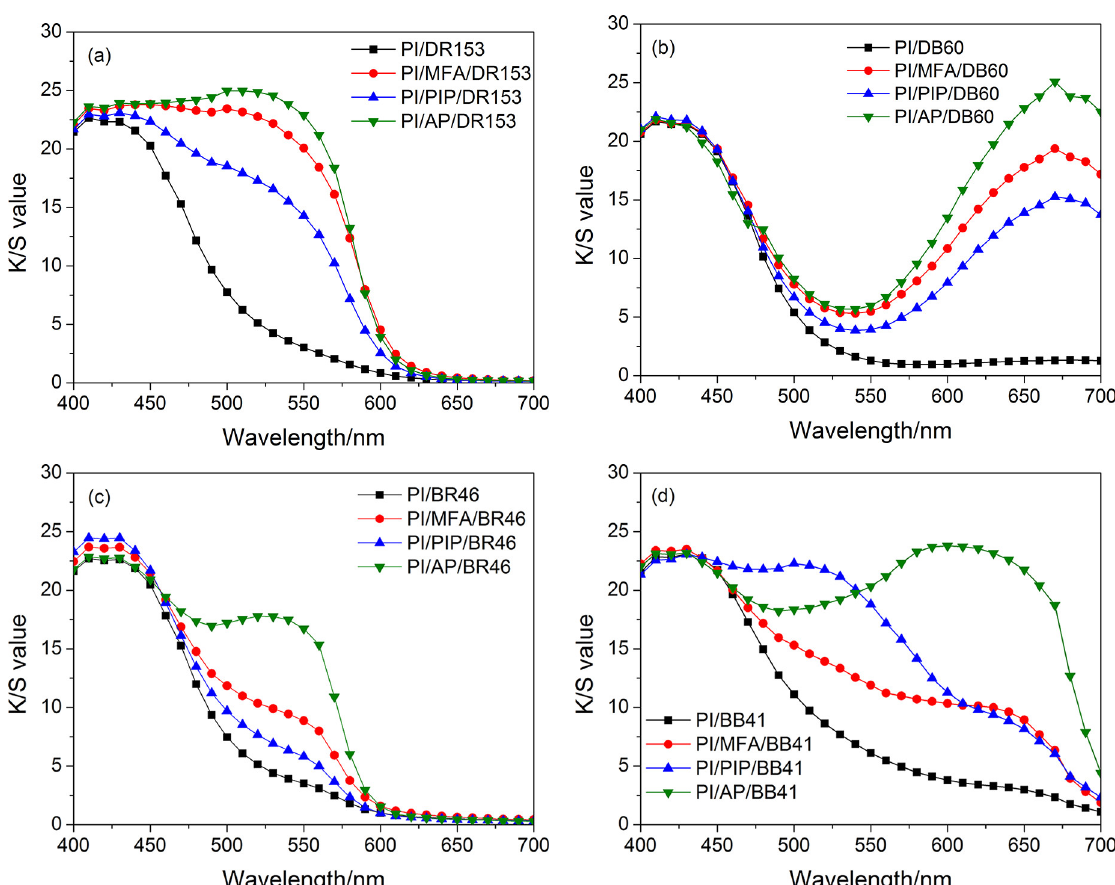
Figure 6. Effect of swelling agents on the color strengths of the PI fibers dyeing with Disperse Red 153 (DR 153) ( a ), Disperse Blue 60 (DB 60) ( b ), Basic Red 46 (BR 46) ( c ), and Basic Blue 41 (BB 41) ( d